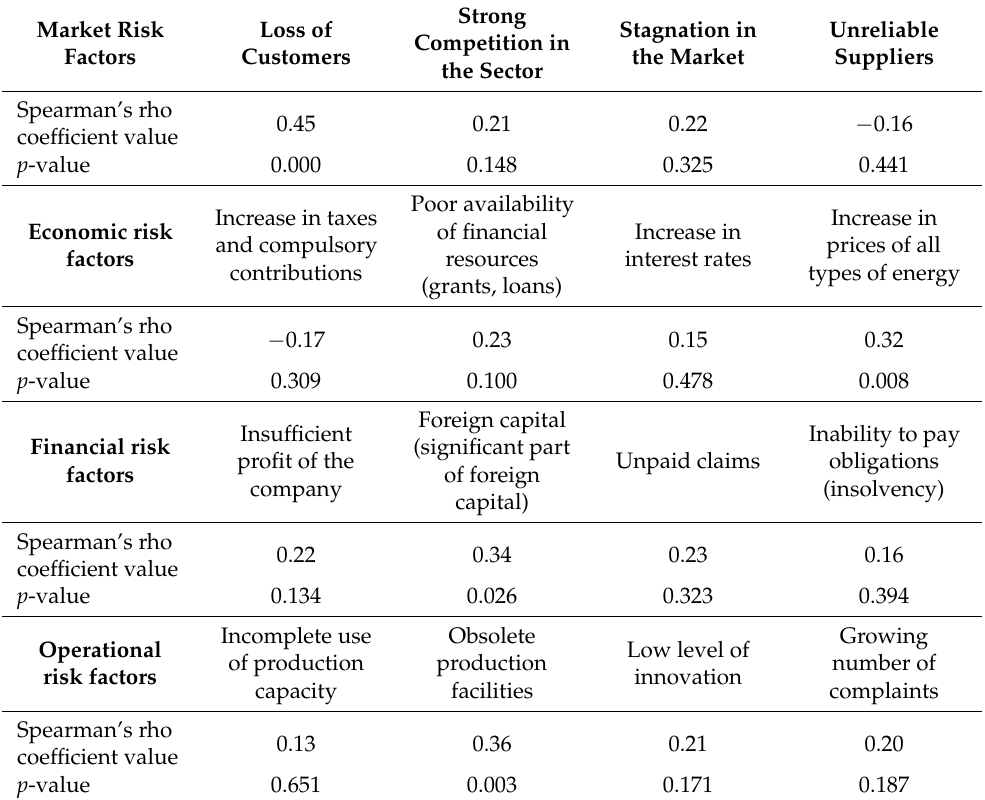
Table 6. The results of the research into the relationships between the intensity of risk and risk management time using the Spearman rank